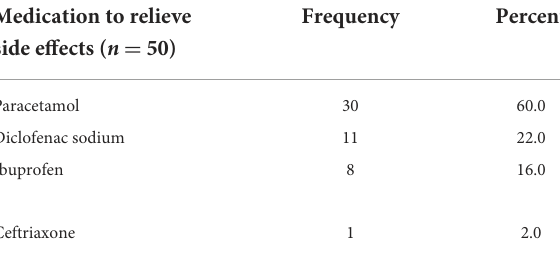
TABLE 12 Medications taken by healthcare workers to relieve the side effects of COVID-19 vaccines, Ethiopia. Medication to relieve